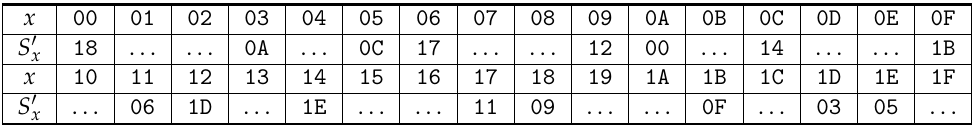
Table 2. 5-bit S-box derived from PRESENT to fill.